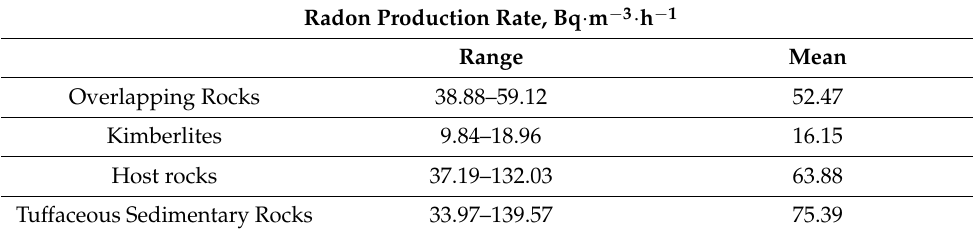
Figure 5. Histogram of radium activity ( a ), emanation coefficient ( b ) and porosity ( c ) for the studied types of rocks. The rate of radon production was calculated for the different types of rocks (Table 3). This parameter is one of the most important for assessing radon in its free state. Table 3. Radon production rate for the studied types of